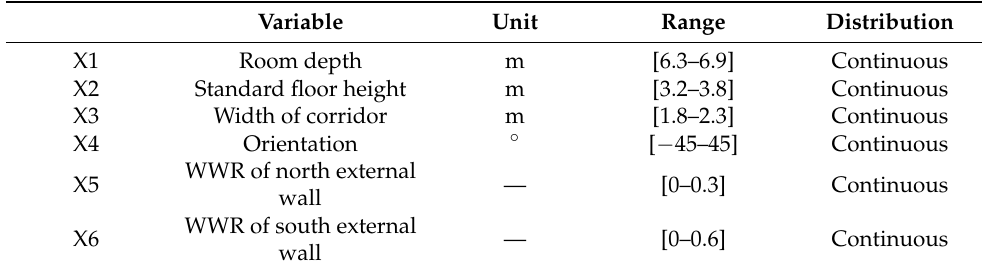
Table 1. Descriptions and range of optimized design parameters.